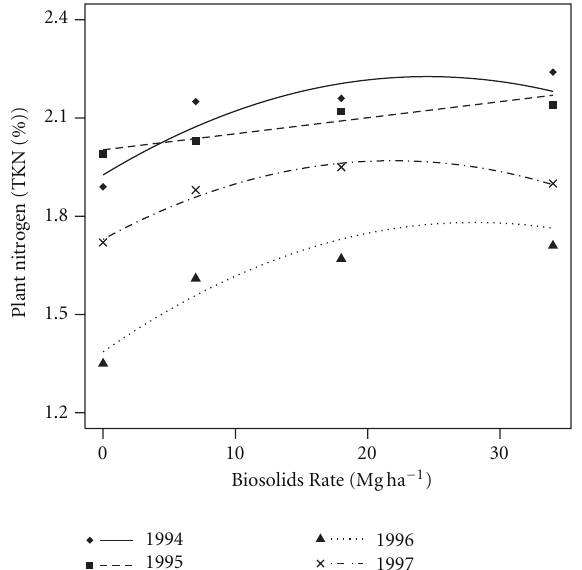
Figure 3: Hilaria mutica total nitrogen concentration (% TKN) as a ff ected by biosolids application and years after a single application. Biosolids were applied in 1994 and forage was analyzed yearly from 1994 to 1997 (redrawn from [8]).